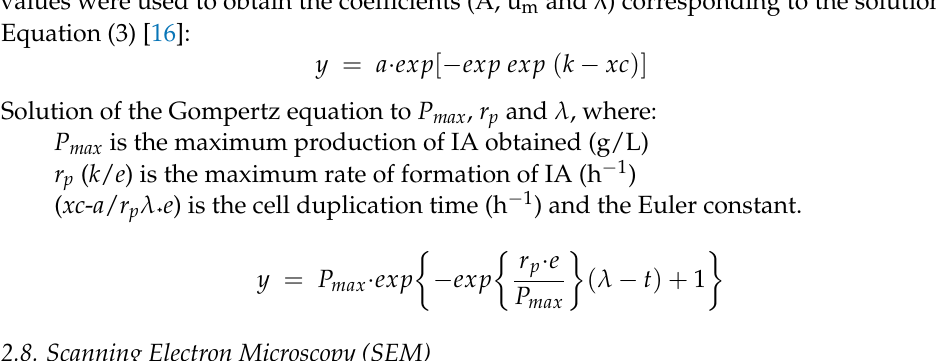
Table 1. Levels of the factors used in the optimization of the maximum production rate of isopentyl acetate.